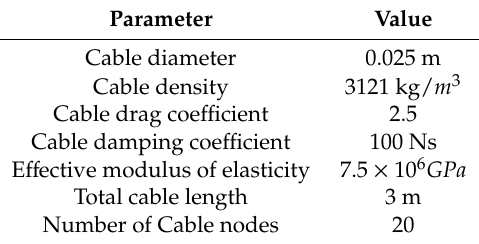
Table 2. Specification of Underwater